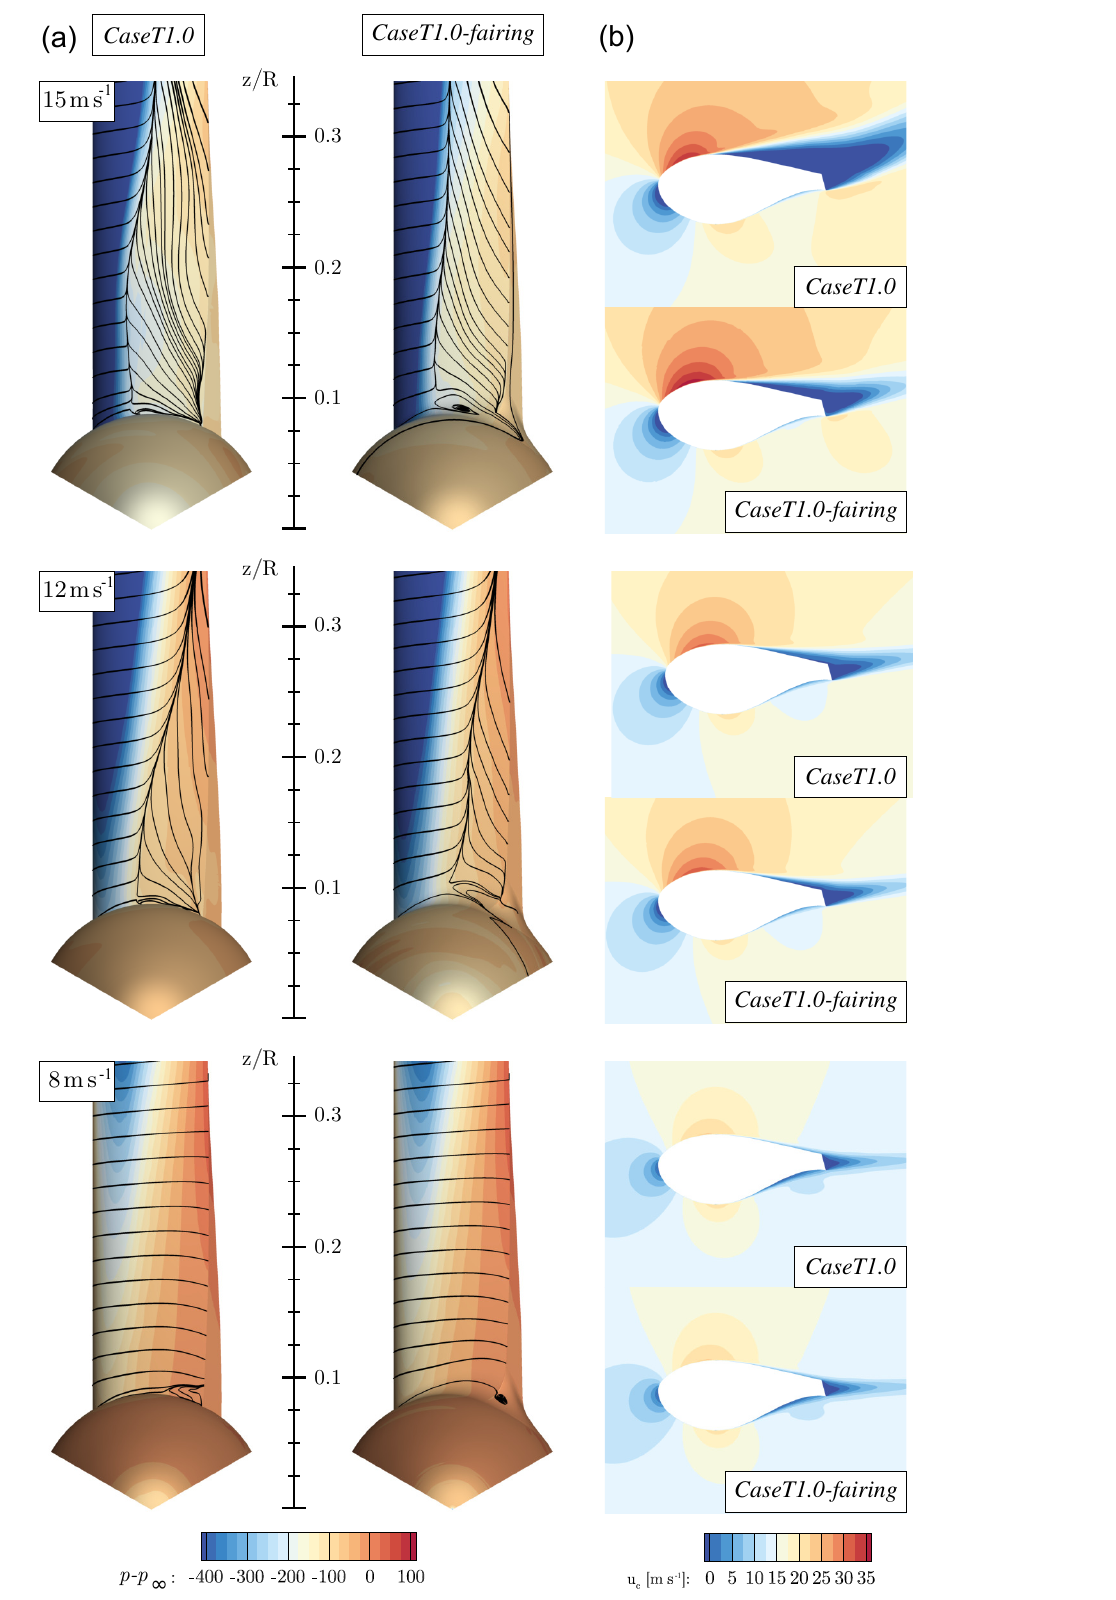
Figure 34. Comparison of the flow field in the root region for CaseT1.0 and CaseT1.0-fairing at off-design wind speeds: U ∞ = 8, 12 and 15ms − 1 . Surface streamlines (column a ) and chord-wise velocity distribution at z/R = 0 . 2 (column b